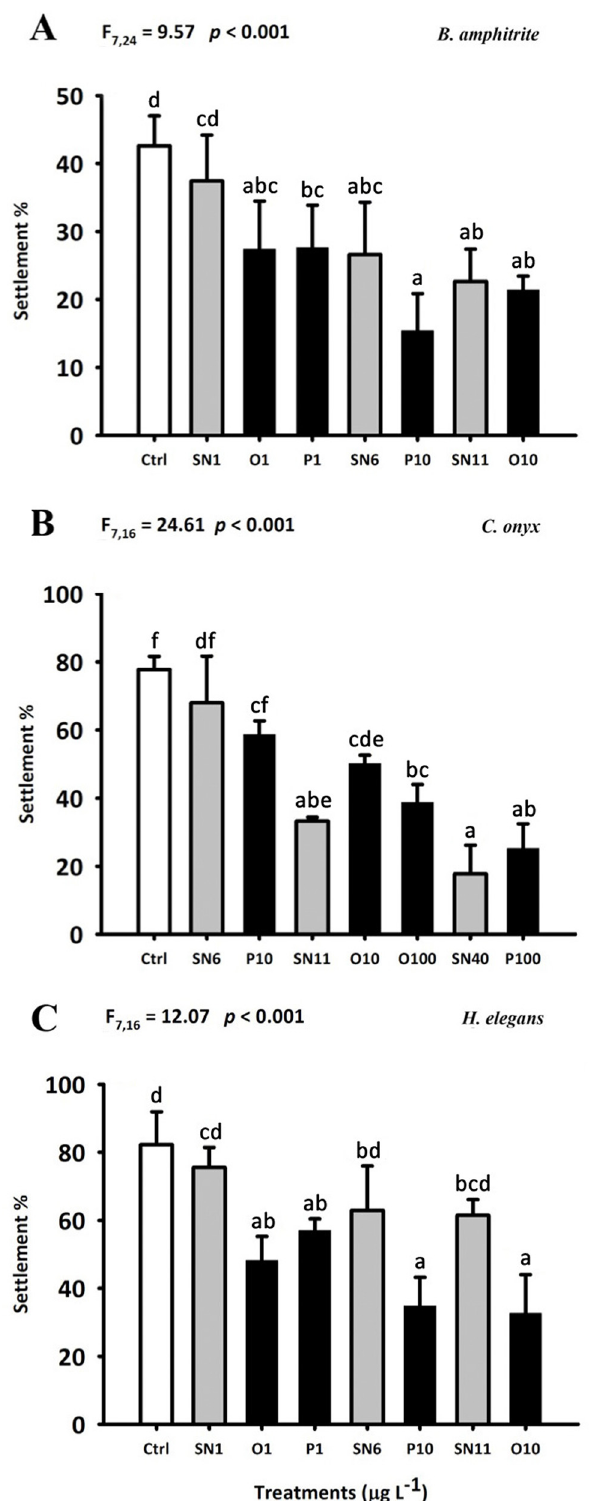
Fig 5. Effect of OAgNPs, PAgNPs and AgNO 3 on the larval settlement of B . amphitrite (A), C . onyx (B) and H . elegans (C). Each bar represents the mean (+ SD) of four replicates (A) or three replicates (B-C). One-way ANOVA was used for the statistics analysis. Different letters above the bar indicate the means that